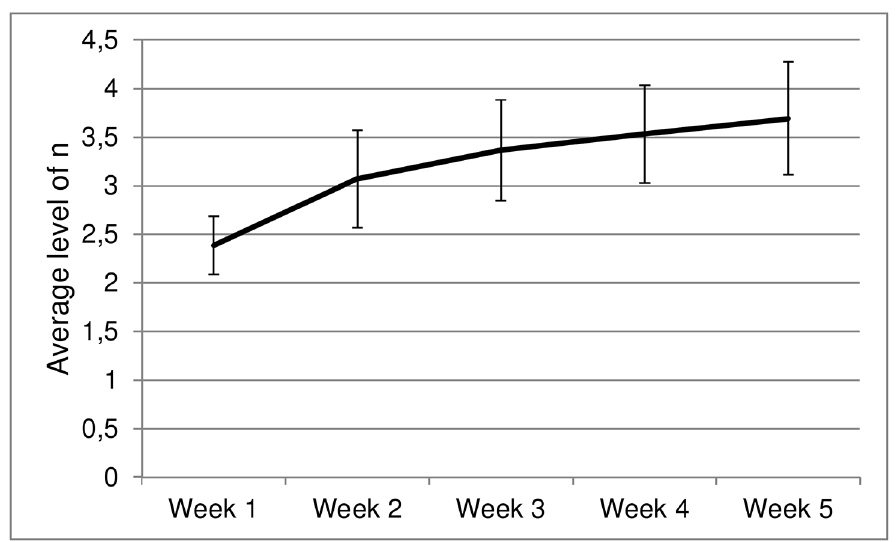
Fig 5. The weekly average level of n achieved in the dual n-back training task. Error bars represent +/- 1 SD.